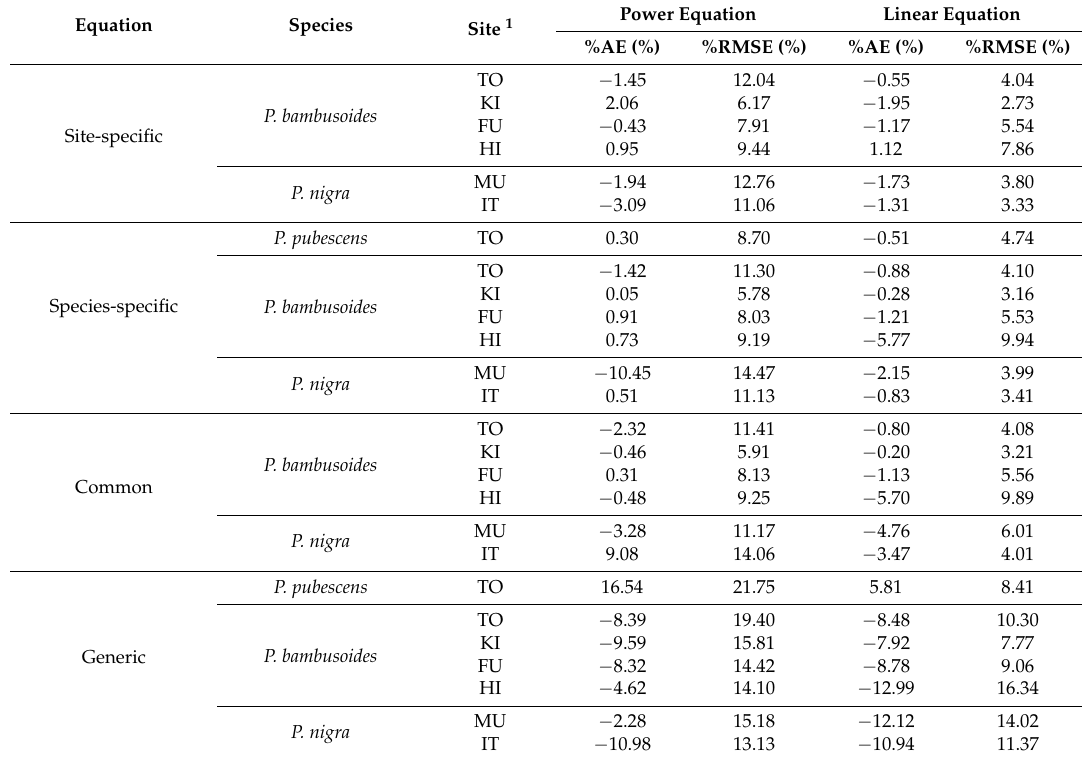
Table 4. Accuracy (%AE) and precision (%RMSE) of the culm surface area estimated by the developed allometric